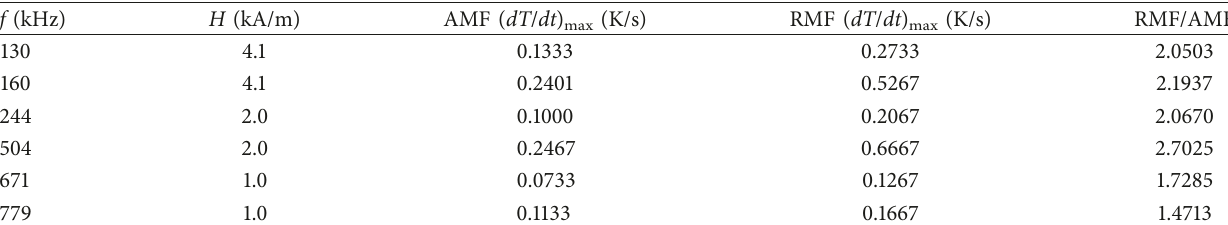
Table 1: Maximal temperature derivative: comparison of AMF and